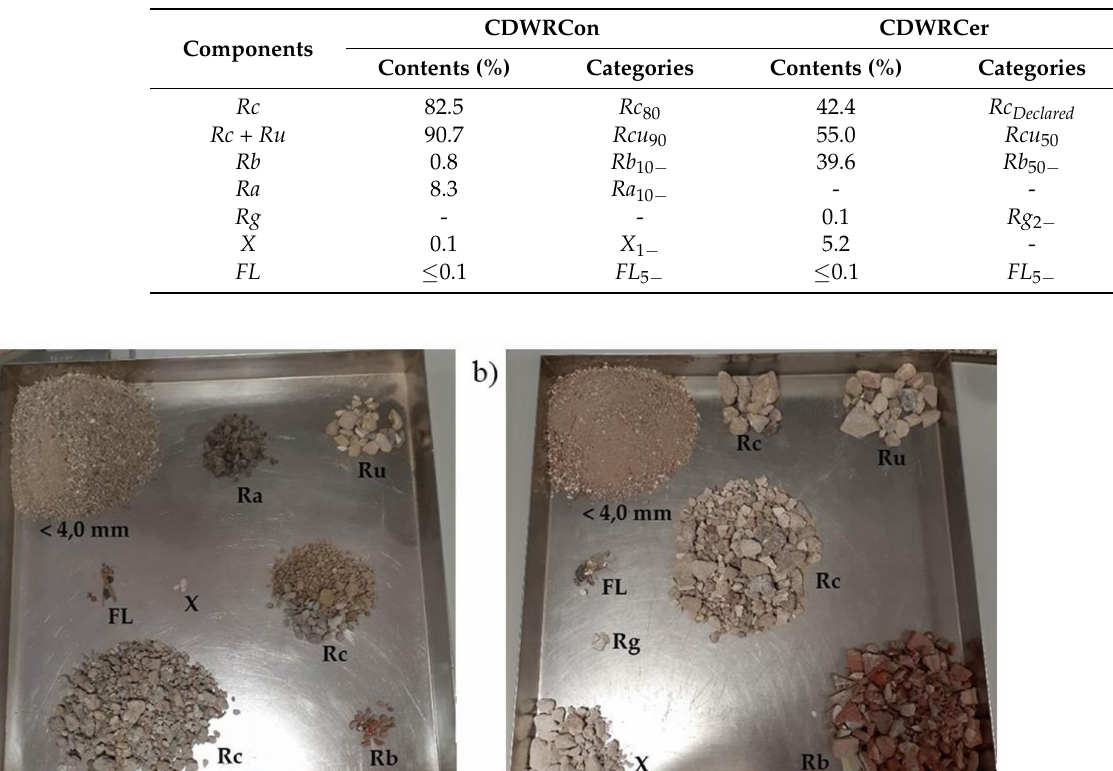
Table 1. Proportions of the different aggregates.